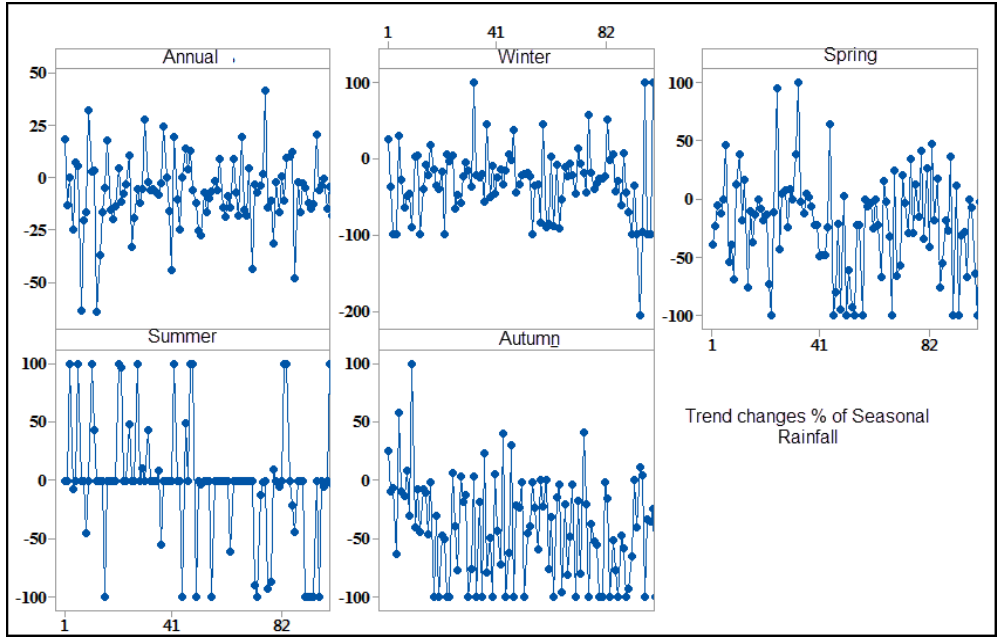
Figure 16. Trend changes percent of forecasted seasonal rainfall.